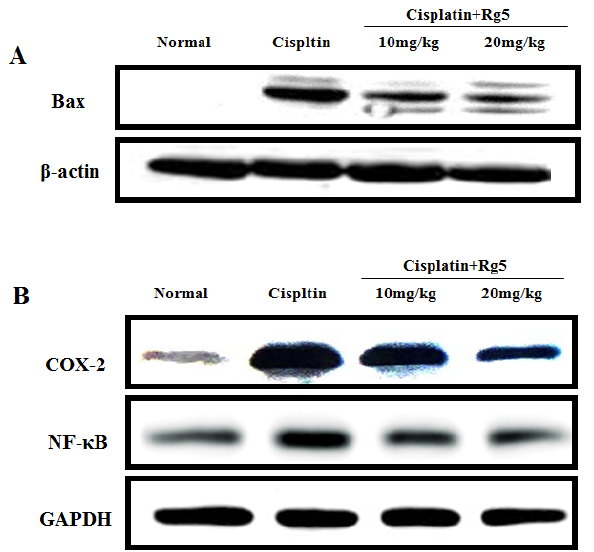
Figure 10. Effects of ginsenoside Rg5 on the protein expression of: Bax ( A ); and nuclear factor ‐ kappa B (NF ‐κ B) p65, and cyclooxygenase ‐ 2 (COX ‐ 2) ( B ). The protein expression was examined by Western blotting analysis in kidney tissues from normal, cisplatin, cisplatin + Rg5 (10 mg/kg), and cisplatin + Rg5 (20 mg/kg).